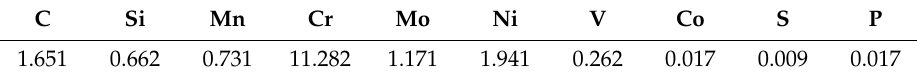
Table 1. Chemical composition of high Cr roller steel in wt % used in